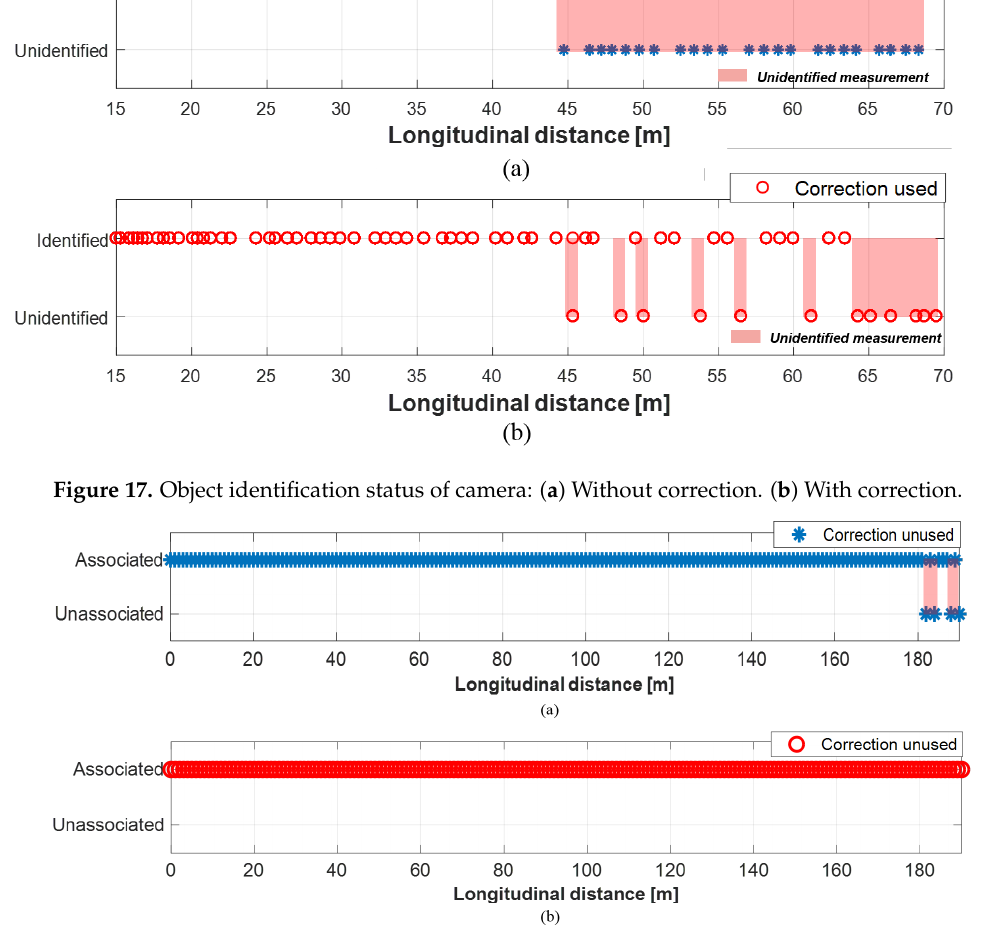
Figure 18. Object identification status of lidar: ( a ) Without correction. ( b ) With